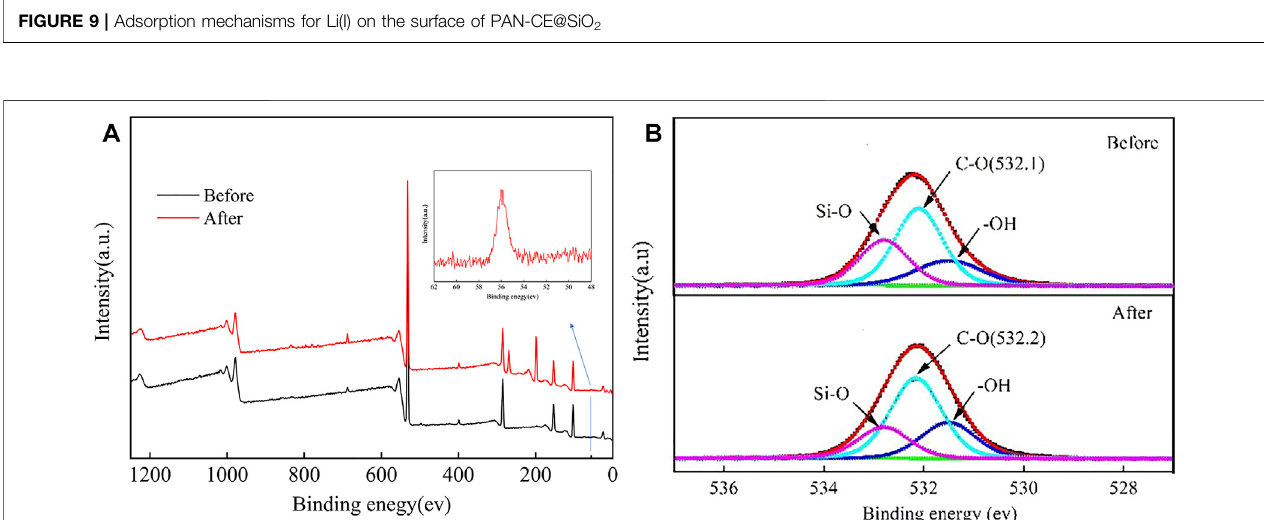
FIGURE 10 | Full-spectrum fi tting (A) and narrow-spectrum fi tting (B) of PAN-CE@SiO 2 by XPS.